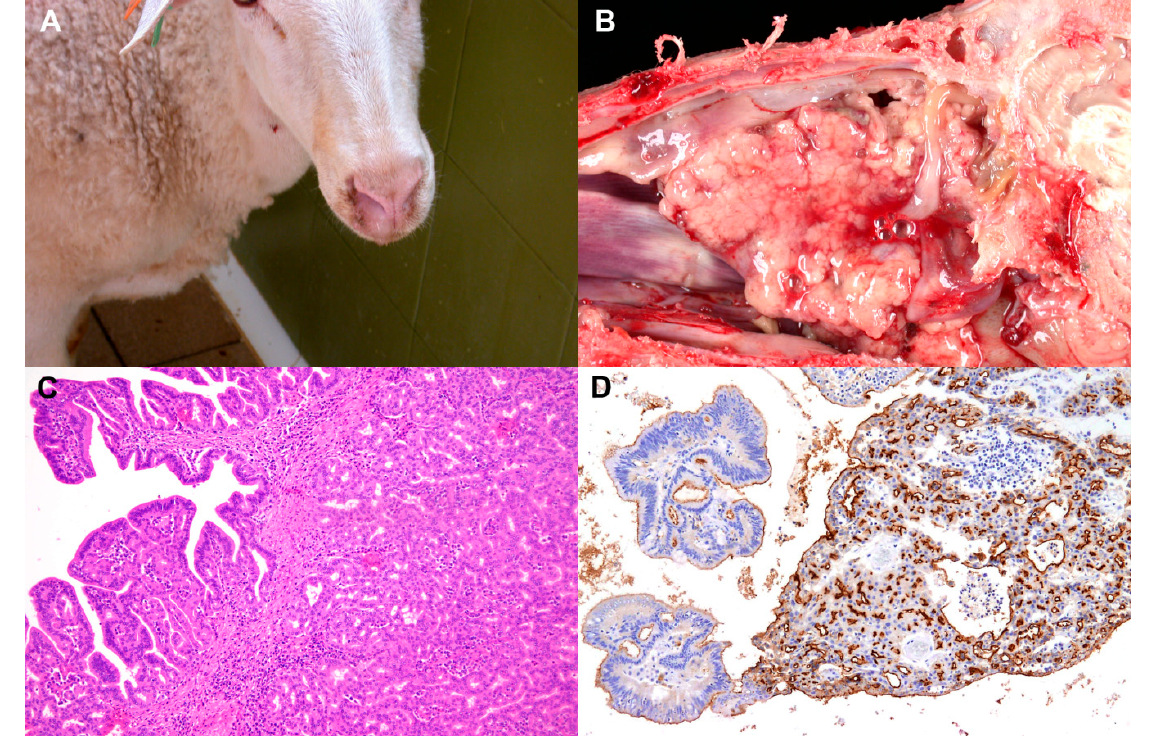
Figure 3. Enzootic nasal adenocarcinoma (ENA) clinical signs and pathology. ( A ) Sheep 3 years old. Right nasal nostril showing sero ‐ mucous fluid discharge. As a consequence, right nostril looks cleaner and less hairy (washed nose). ( B ) Sheep 4 years old. Sagittal section of the skull showing replacement of normal ethmoidal turbinate by a multinodular or polypoid mass covered by mucus pressing close structures. ( C ) Histopathology of ENA. Epithelial cells proliferate into acinar and tubular patterns in inner parts; meanwhile, external zones show a predominant papillary pattern. Hematoxylin ‐ Eosin. 100×. ( D ) Histological section of ENA. Immunohistochemistry. Monoclonal antibody against JSRV Env protein. Positive material is almost exclusively located on the apical membranes of both types of growths. 100×.